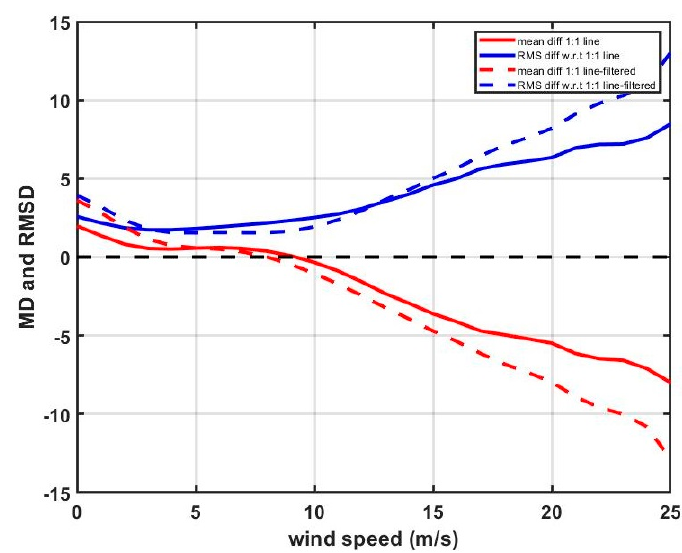
Figure 12. Mean difference and RMS difference statistic on CYGNSS retrieved winds before and after QC filter.